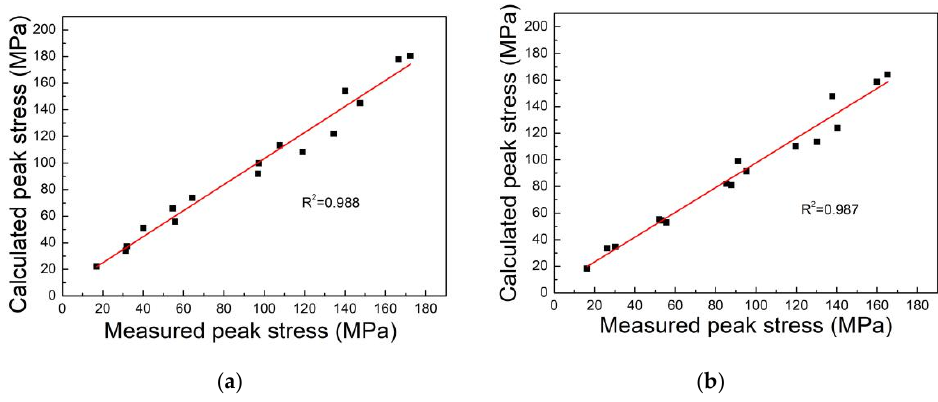
Figure 5. Comparison of the calculated and measured peak stress for MZC ( a ) and MZCM ( b ).